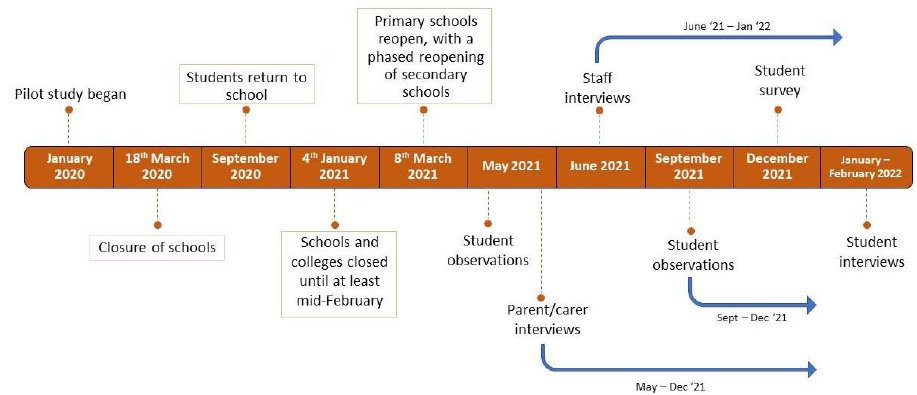
Figure 1. Timeline of data collection and key educational COVID milestones.